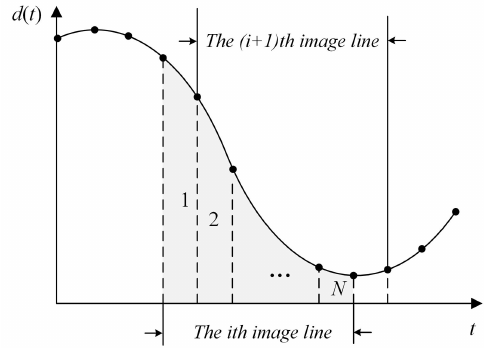
Figure 3 . Illustration about division of jitter